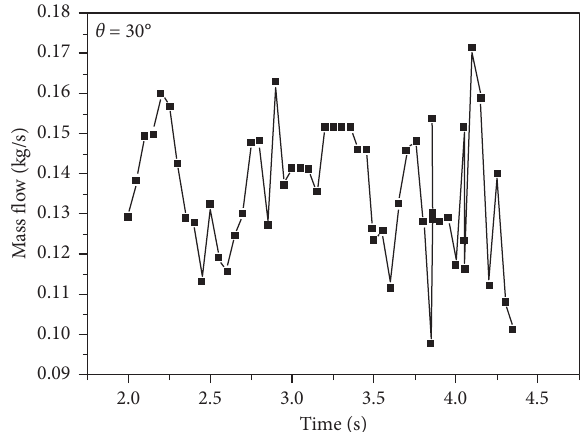
Figure 4: Simulation of the dense flow rate of the gravity-driven